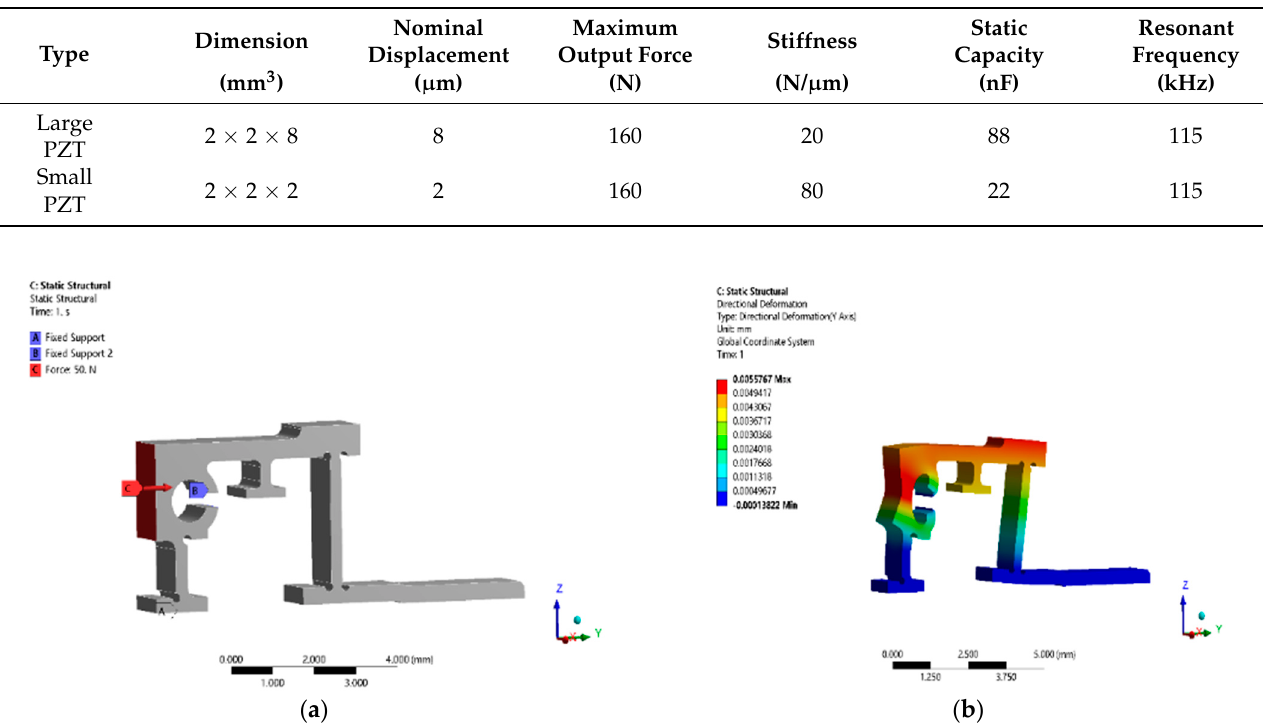
Figure 9. Simulation process ( a ) and results ( b ) of flexible hinge displacement. Table 1. Characteristic parameters of PZT.